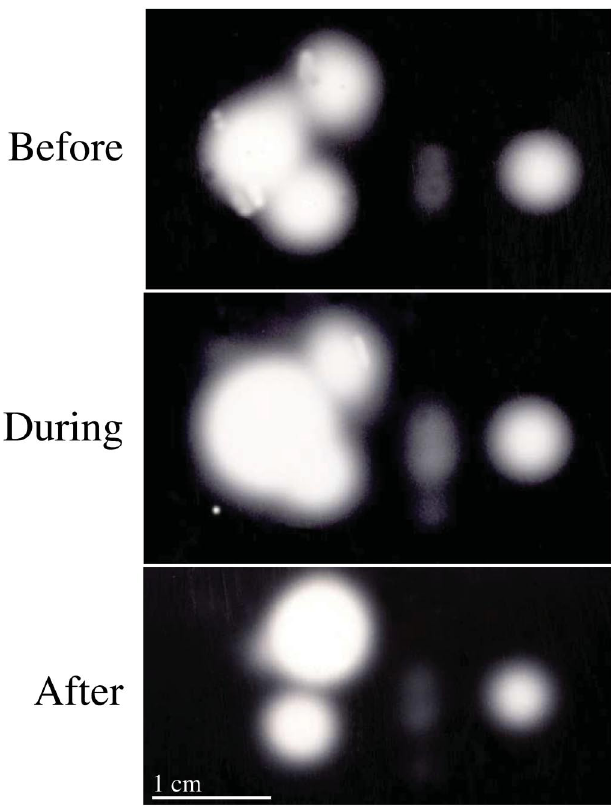
FIG. 5. Polaroid pictures, taken over a 10 min period, of an emitter pattern before, during and after a breakdown